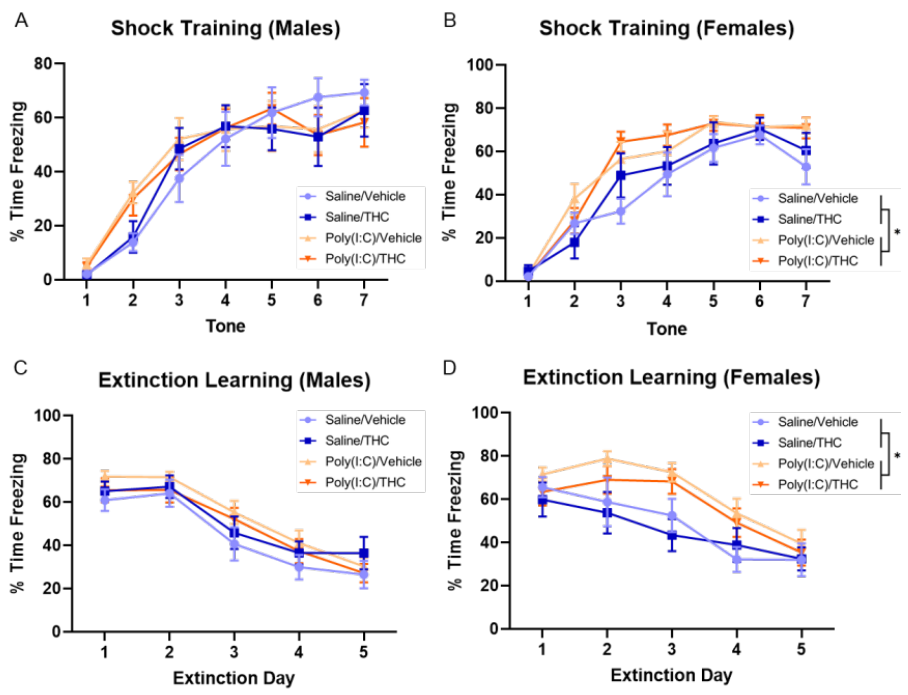
Figure 5. Fear conditioning and extinction. ( A , B ) The percent of time that male ( A ) and female ( B ) mice spent freezing during the tone in the training phase where mice received a foot shock at the end of the tone. ( C , D ). The percent of time that male ( C ) and female ( D ) mice spent freezing during the first five tones on each day the extinction phase. The data for four female mice on day two and